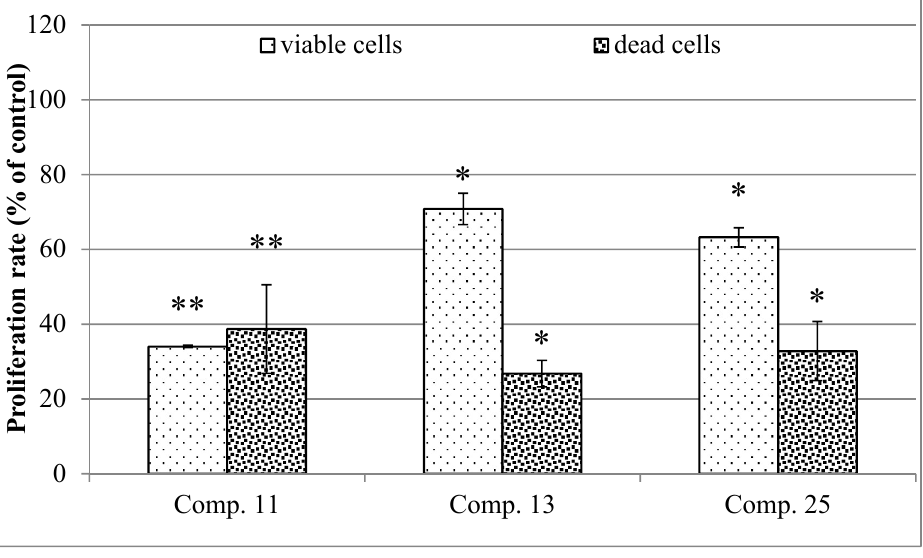
Figure 4. Proliferation rate assessment in HaCaT cells treated for 48 h with compounds 11 , 13 and 25 , applied at concentrations 8 µM, 8 µM and 37 µM, respectively. Data are expressed as means ± SD from three independent experiments performed in triplicate. Statistical significance: * p < 0.01 and ** p < 0.001 refer to the control (untreated) cells.